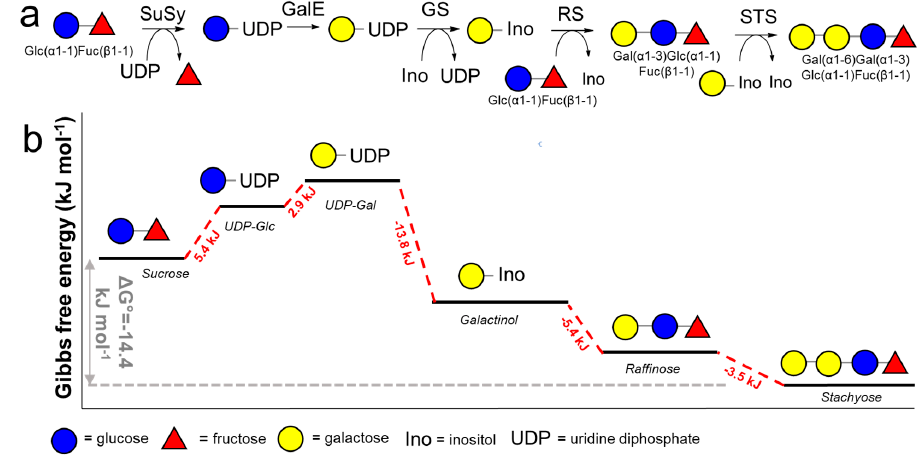
Figure 7. Enzymatic cascade for the production of stachyose from sucrose with glycosyltransferases. ( a ). The standard Gibbs free energy changes of the individual reactions ( Δ G°s, red) and the total reaction ( Δ G°, grey) shown in ( b ) [183]. The Δ r G’° represents the change of Gibbs free energy and was calculated using the eQuilibrator web interface (http://equilibrator.weizmann.ac.il) [155] using the following conditions: ionic strength 0.1 M, pH 7.0, 1 mM of component, 298 K. Abbreviations: UDP- D -glc, UDP- D -glucose; UDP- D -gal, UDP- D -galactose, SuSy, Sucrose synthase; GalE, UDP- D -glucose-4-epimerase; GS, galactinol synthase; RS, raffinose synthase; STS, stachyose synthase.